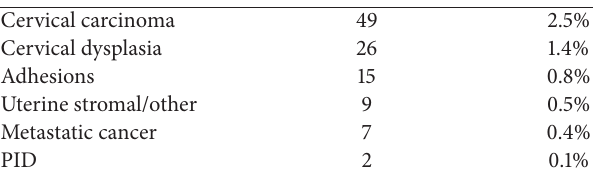
Table 1: Demographics of all 1924 patients in